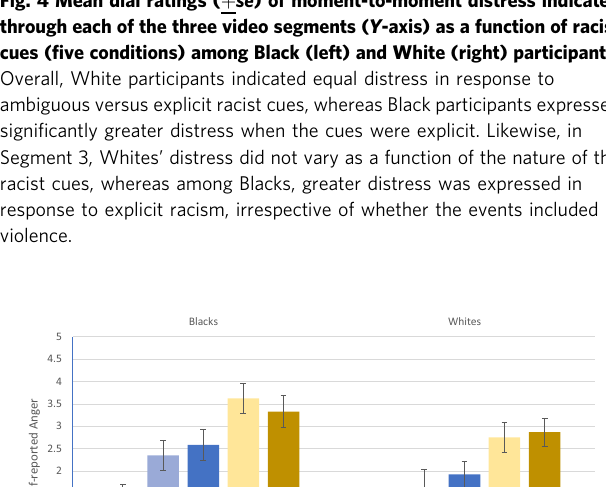
HUMANITIES AND SOCIAL SCIENCES COMMUNICATIONS| (2021) 8:34